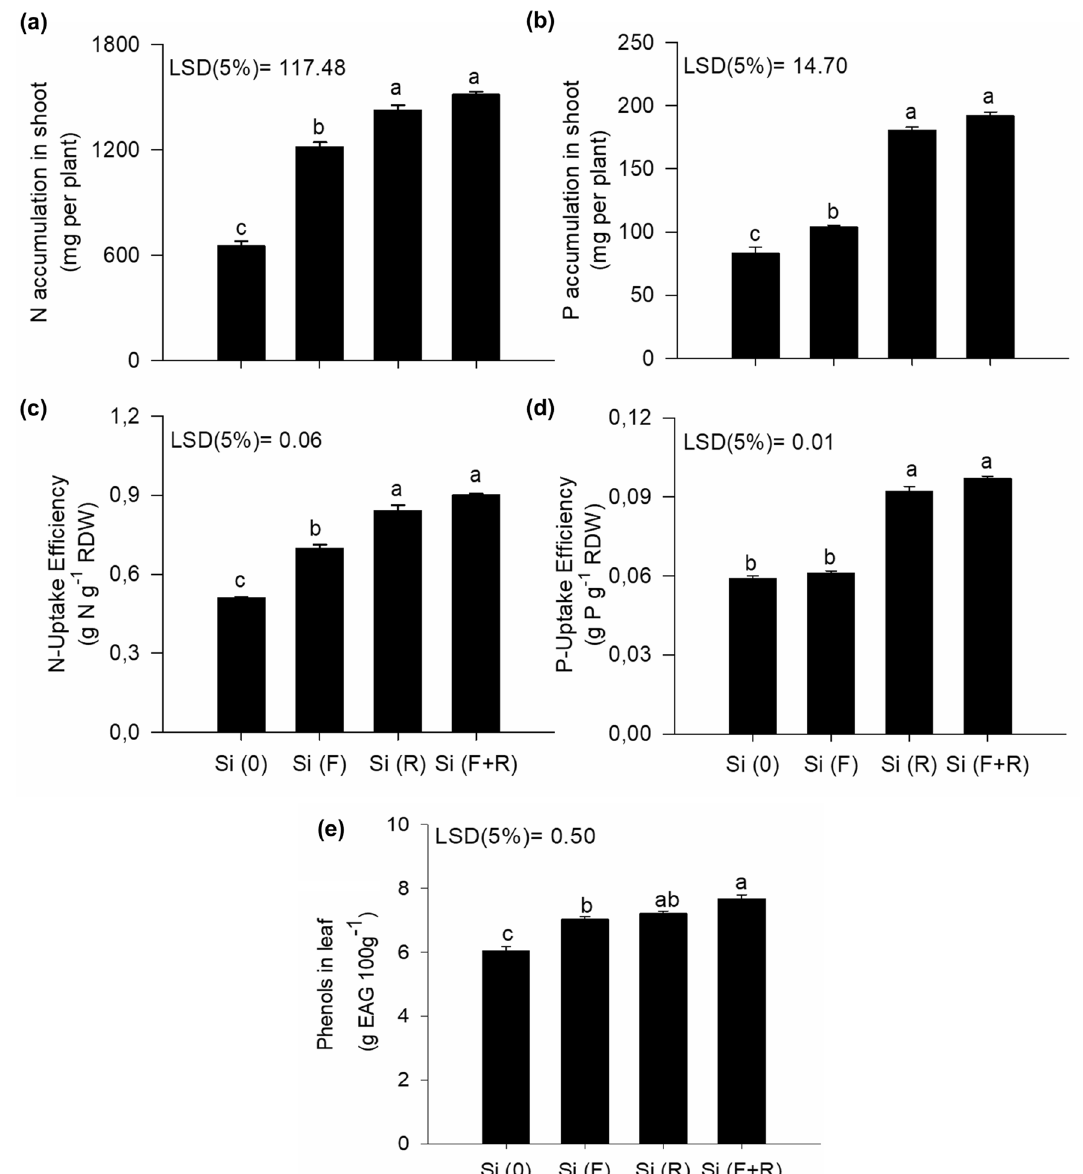
Figure 2. Accumulation of N ( a ), and P in the shoots ( b ), uptake efficiency of N ( c ) and P ( d ) and phenolic compounds in the leaves ( e ) of quinoa plants, according to different forms of Si application; no Si [Si(0)]; foliar Si application [Si(F)]; root Si application [Si(R)]; combination between root and foliar application [Si(F + R)]. Letters indicate significant differences between the forms of Si application (p < 0.05); least significant difference [LSD]. The vertical bars represent the standard error of the